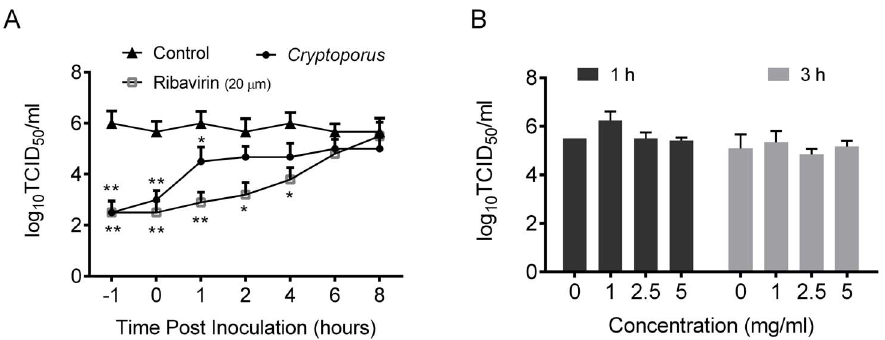
Figure 2. Cryptoporus volvatus extract acts at an early and late stages in the replication cycle. (A) Time course analysis of the extract inhibitory effects on influenza A virus replication. MDCK cells were infected with A/WSN (H1N1) at an MOI of 1, and then at different time points, treated with the normal saline control, extract (5 mg/ml), or ribavirin (20 m m). Virus titer at 9 hpi was determined. (B) The Cryptoporus volvatus extract did not inactivate influenza virus directly. Incubating the A/WSN (H1N1) virus with different concentrations of the extract at 37 ˚ C for 1 h or 3 h, then virus titer was determined in MDCK cells. Data are representative of three independent experiments (mean ¡ SEM). Statistical significance was analyzed by One-way ANOVA . * P , 0.05 ; ** P , 0.01